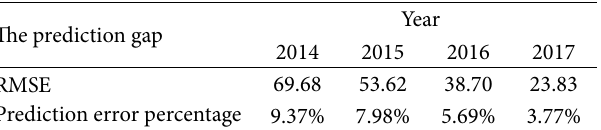
Figure 6: The comparison of the real data with the predicted data by LSTM of four years. Table 2: The prediction gap between the real values and predicted values of four years.